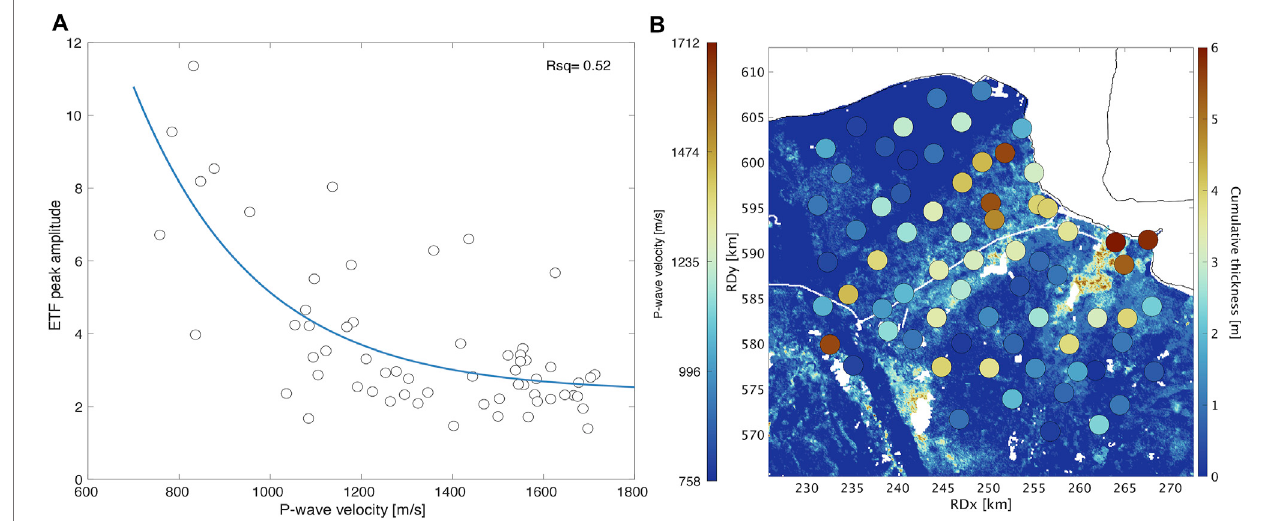
FIGURE 10 | (A) Correlation between P-wave velocities for the top 50 m and ETF peak amplitudes, fi tted with an exponential decaying function ( Eq. 4 ). (B) Spatial distribution of the P-wave velocity values (Hofman et al., 2017) for the top 50 m for each borehole location (circles) plotted on top of the cumulative thickness map of Holocene